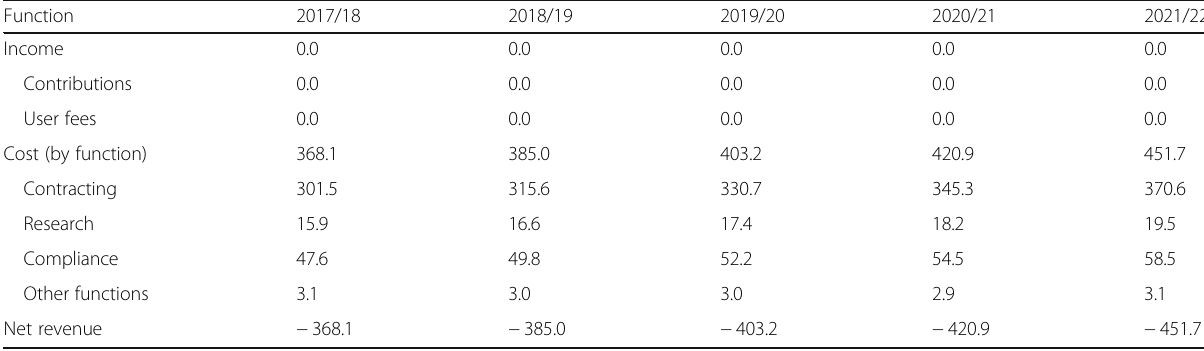
Table 2 Total revenue, administrative costs and net effects of Purchaser Scenario (MWK million)